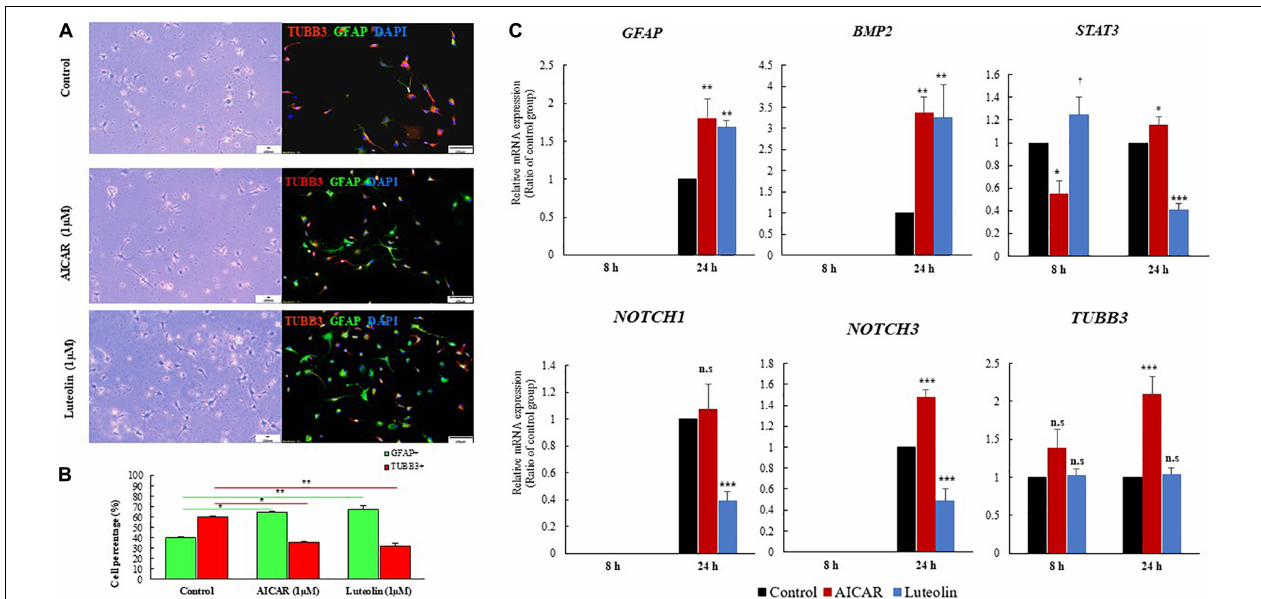
FIGURE 2 | Luteolin treatment (1 µ M) for 24 h promoted differentiation of hNSCs into astrocytes. (A) , Images of differentiated hNSCs treated with differentiation medium (Control), 1 µ M of AICAR, or 1 µ M of Luteolin fixed after 24 h and stained with TUBB3 (red), GFHP (green), and counterstained with DAPI (blue), unstained cells Scale bar = 100 nm, stained cells Scale bar = 100 µ m, Magnification = × 10. (B) Quantification of GFAP and TUBB3 positive cells among total DAPI-positive cell. Data are expressed as mean ± SEM of two independent experiments. (C) RT-qPCR validation results obtained after 8 and 24 h of treatment with differentiation medium, 1 µ M Luteolin or 1 µ M AICAR. Data are expressed as mean ± S.D. of three independent experiments. ***p < 0.001, **p ≤ 0.01, *p < 0.05, and † p < 0.1 (ANOVA followed by Dunnett’s post hoc